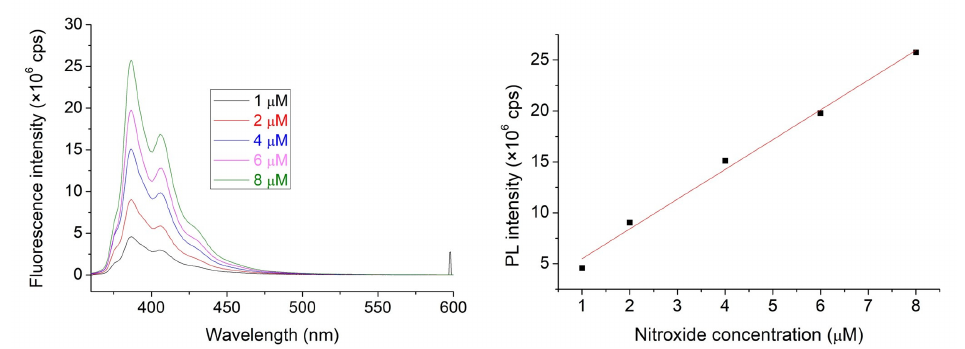
Figure 2. The emission spectra of NO with increasing concentration within the 1–100 μ M range ( left ). Linear correspondence of emission to the fluorophore nitroxides concentration (adj. R 2 = 0.990, right